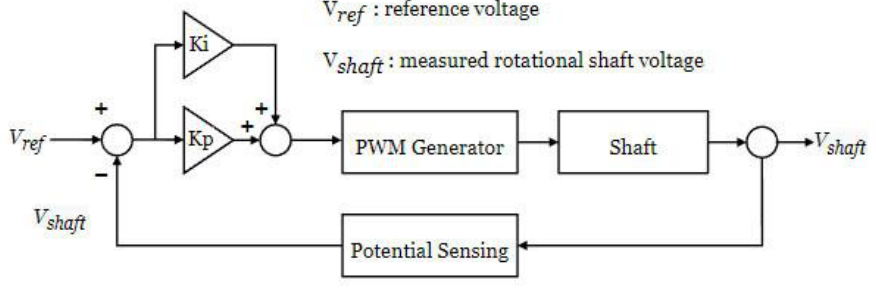
Figure 3. PI control algorithm.